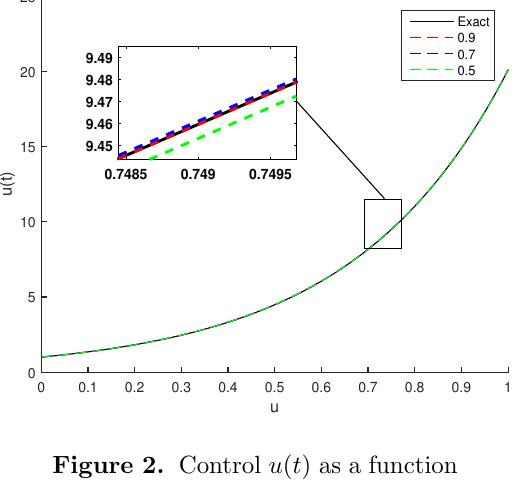
Figure 2. Control u ( t ) as a function of t for the Example 1 for m = 7 and different values of α (green: α = 0 . 5, blue: α = 0 . 7, red: α = 0 .